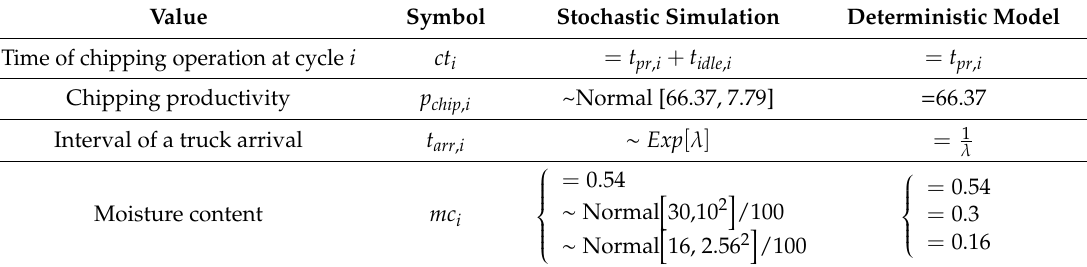
Table 3. Di ff erence between the stochastic and deterministic